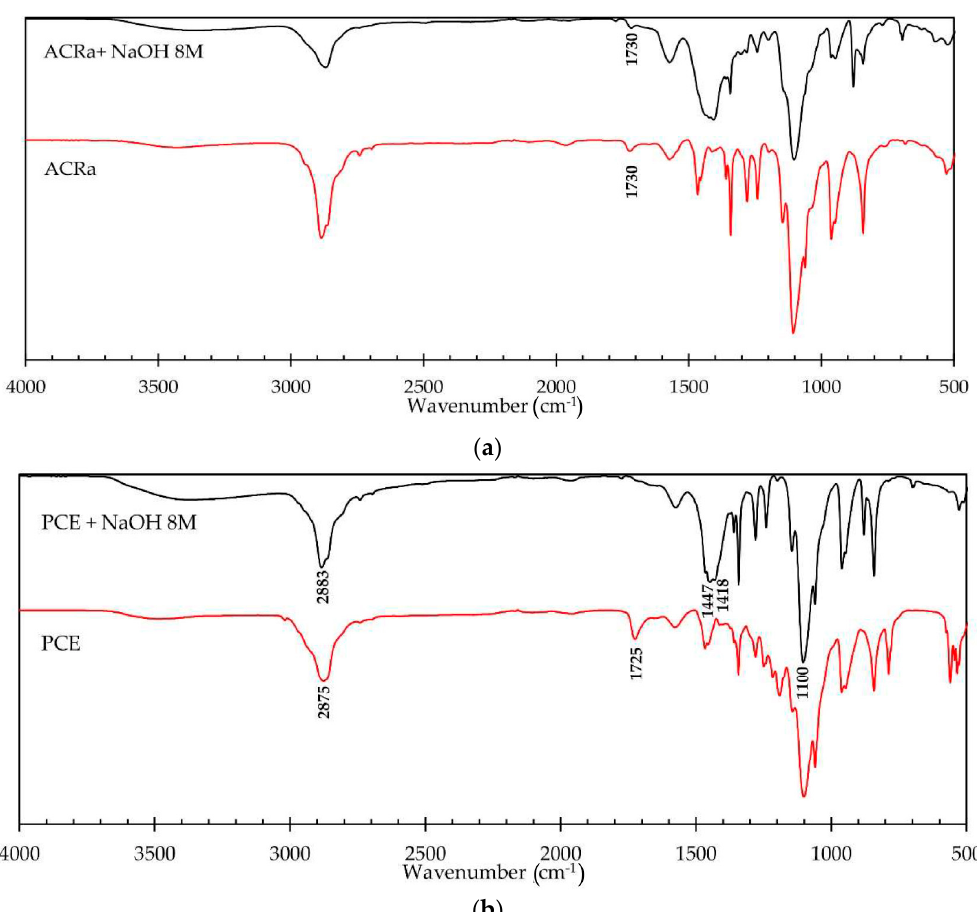
Figure 3. FT-IR spectra for ( a ) ACRa; and ( b ) PCE superplasticizers dried in a vacuum dryer and after mixing with an 8 M NaOH solution.